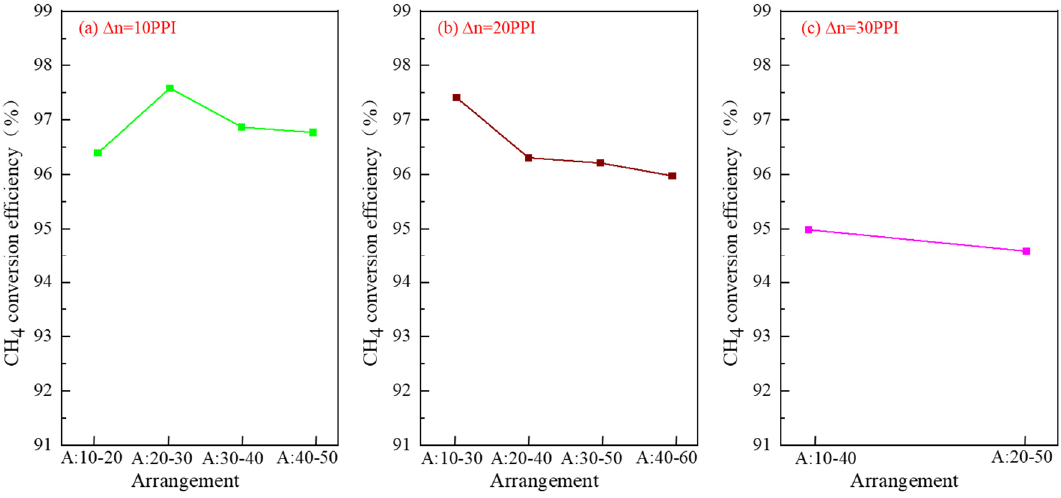
Figure 13. CH 4 conversion efficiency at different Δ n.